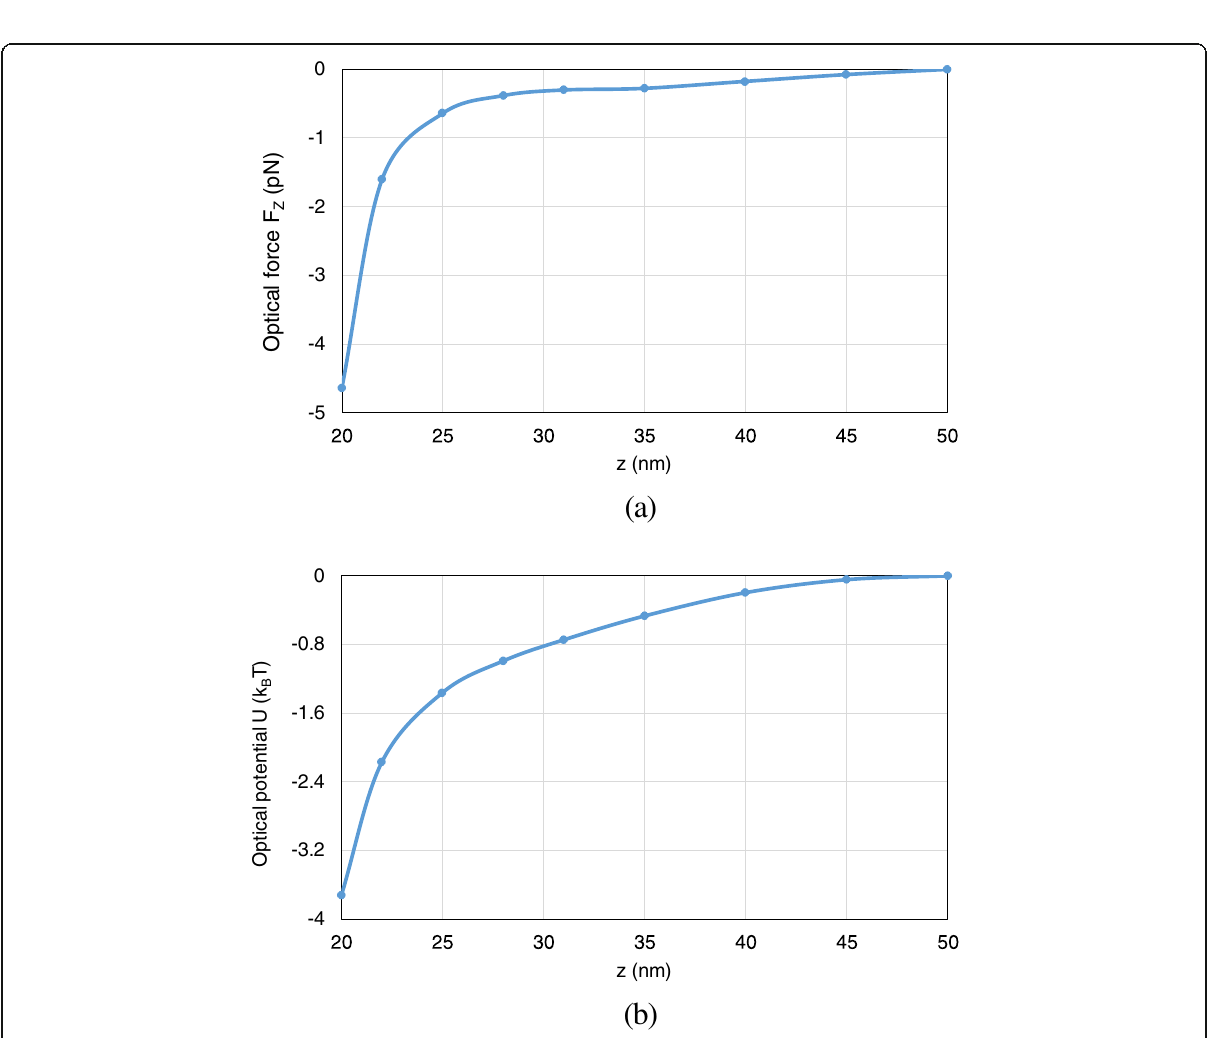
Fig. 13 The optical forces and optical potentials exerted on the nanosphere in the system of gold truncated cone dimer, when the nanosphere moves from (0, 0, 50 nm) to (0, 0, 20 nm). a The optical forces. b The optical